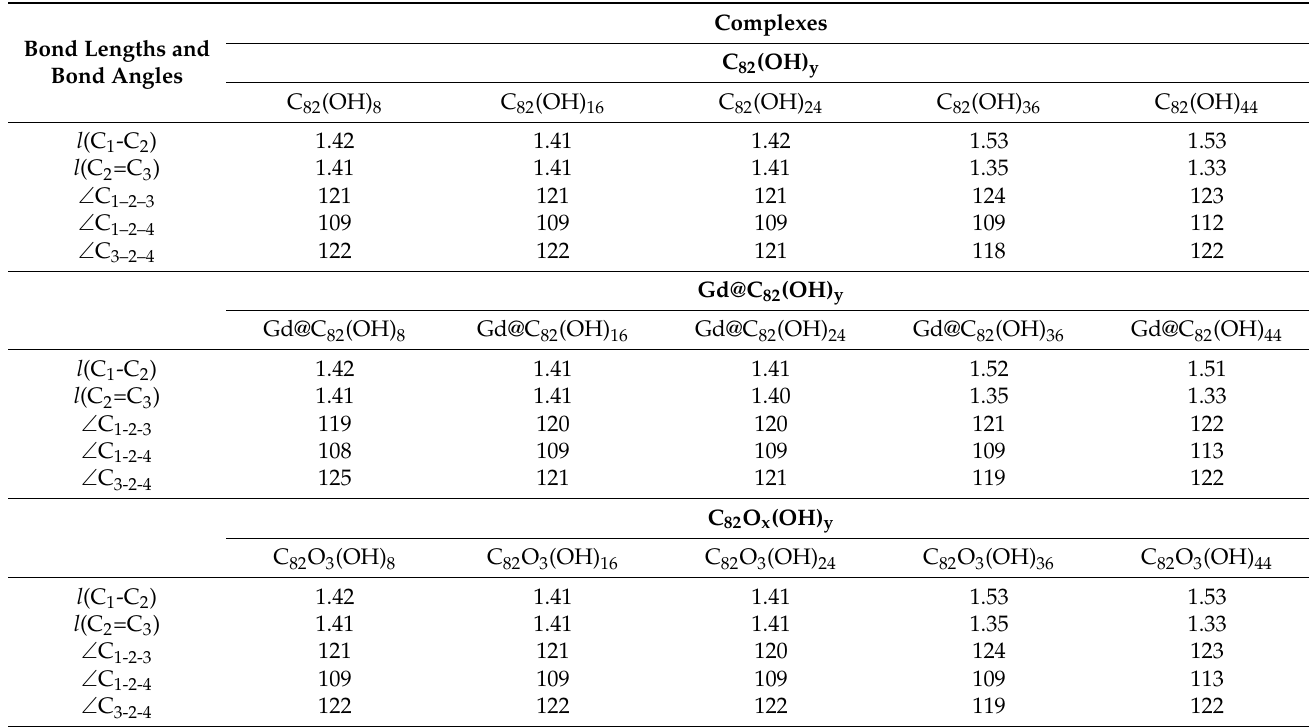
Table 1. Structural parameters * of Gd@C 82 O x (OH) y and C 82 O x (OH) y